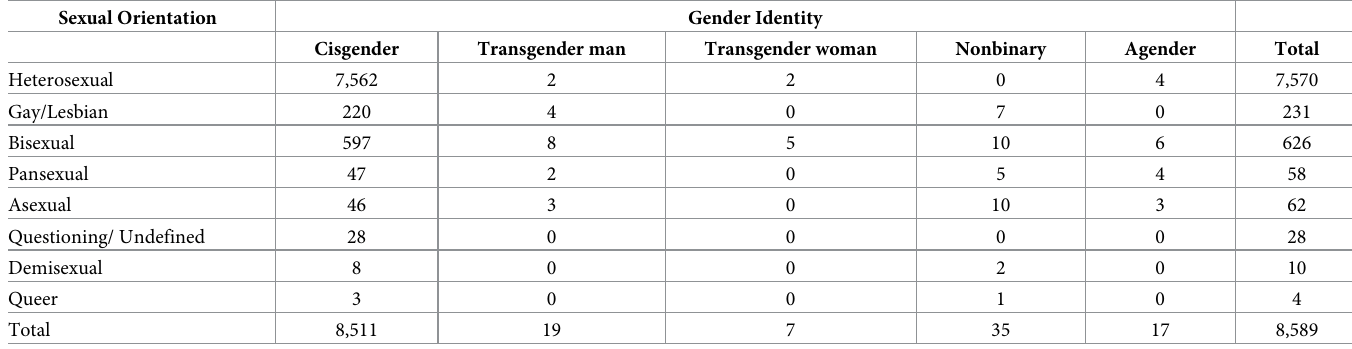
Table 1. The frequency of different sexual orientations and gender identities among the